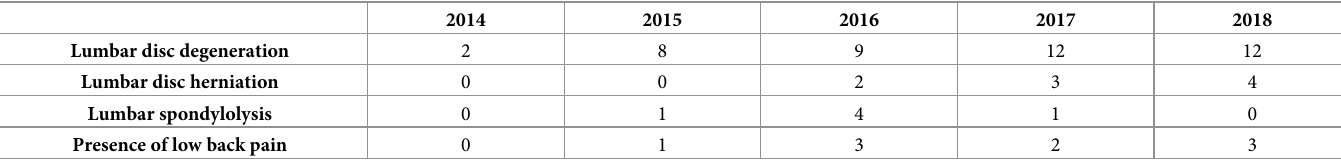
Table 2. Temporal changes of lumbar degeneration findings on MRI and LBP over a 5-year period.